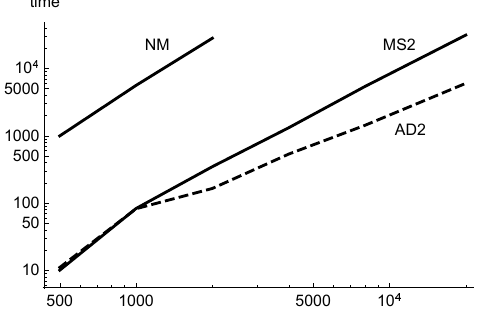
Figure 4. Log-log plot of the execution times of AD2 , MS2 , and NM versus N